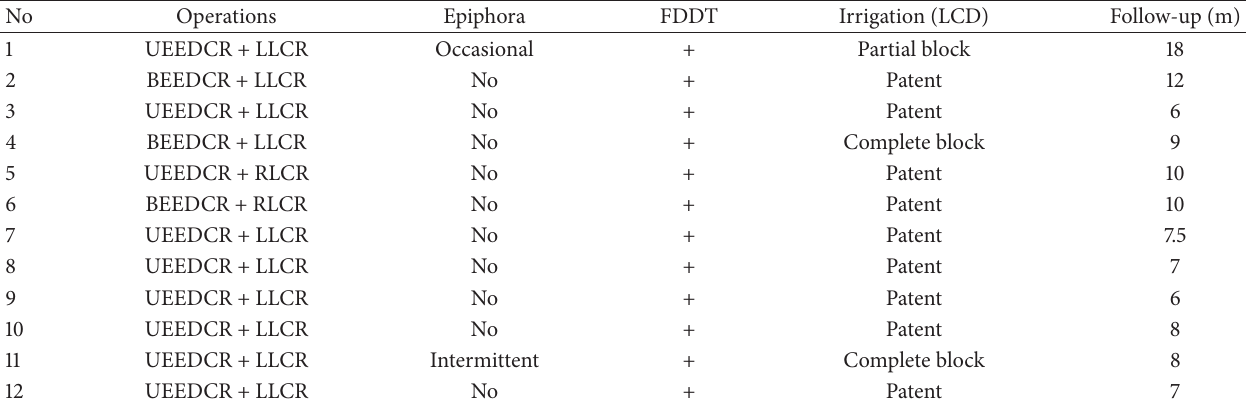
Figure 3: Postoperative photographs: (a) shows no remarkable skin scar presented at the site of lower lid incision; (b) shows an intranasal ostium widely opened, with fluorescein dye appearing around the intranasal ostium; (c) shows the smooth lumen when a lacrimal endoscope is used to examine the repaired lower canaliculus. Table 2: The surgical outcomes in 12 patients with dacryocystitis and canalicular